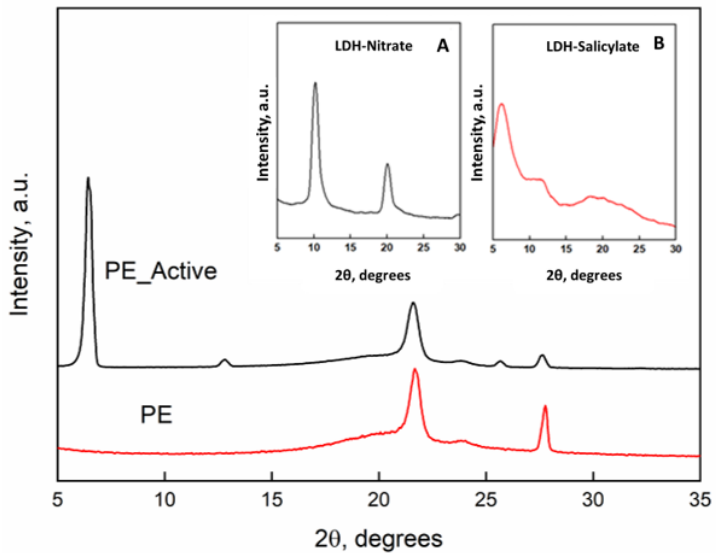
Figure 1. X-ray diffraction patterns of unfilled PE and PE-Active filler. Inset: ( A ) pristine LDH in nitrate form and ( B ) LDH hosting salicylate.